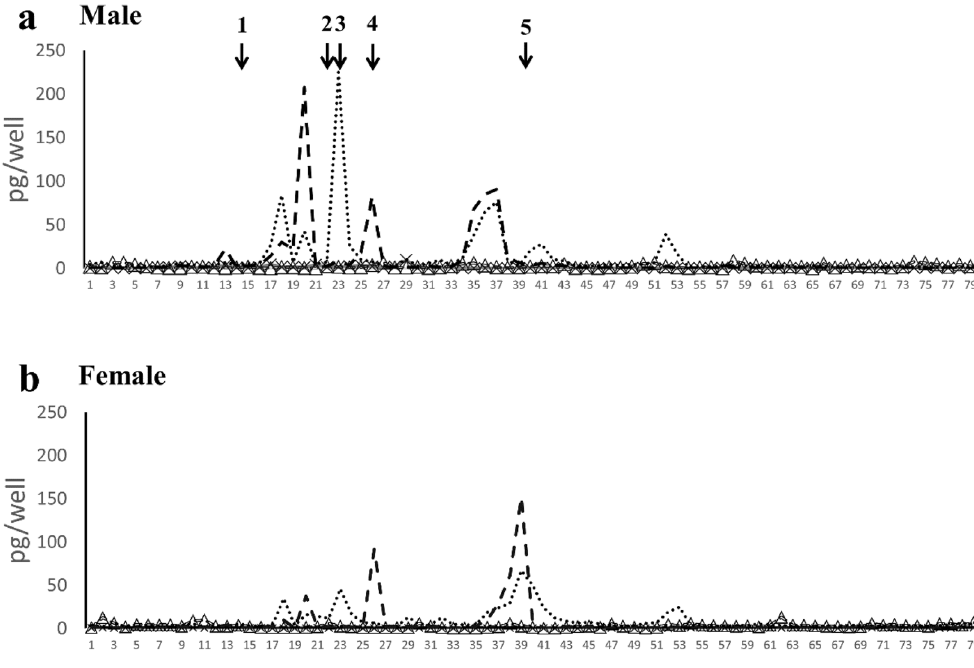
Figure 5. Immunoreactivity of HPLC elutions of Formosan macaque FGMs detected through EIA analyses for cortisol, corticosterone, 11β-hydroxyetiocholanolone, and 11-oxoetiocholanolone following anesthesia stimulation. The number and arrow above HPLC profiles indicate the elution positions of reference standards: (1) cortisol (14); (2) corticosterone (22); (3) 11β-hydroxyetiocholanolone (23); (4) 11-oxoetiocholanolone (26); and (5) testosterone (40).